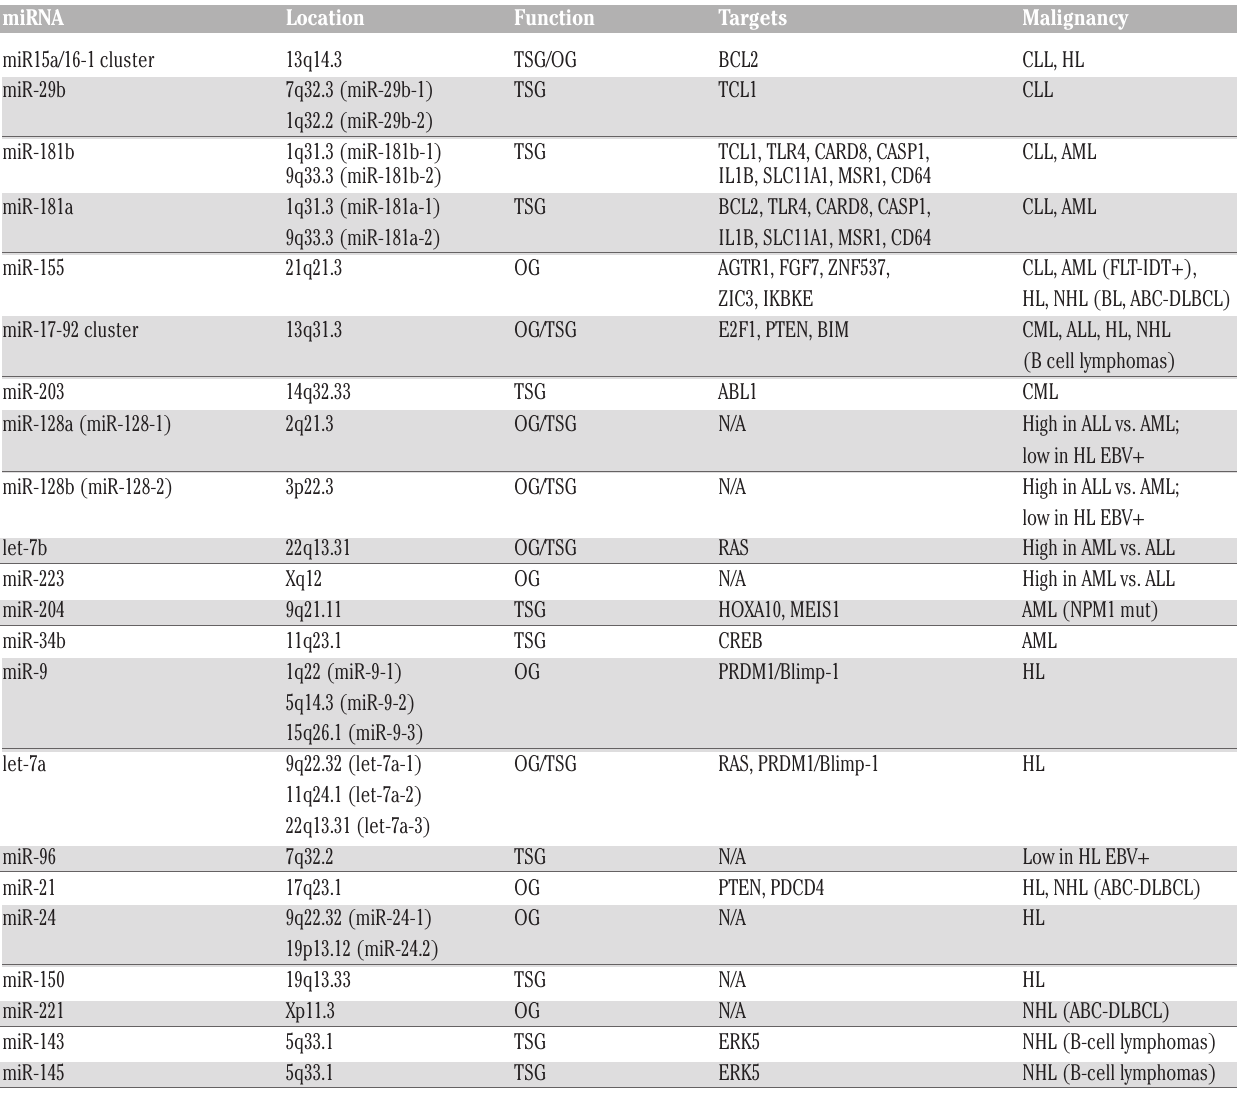
Table 1. Main aberrantly expressed miRNAs in hematologic malignancies. miRNA